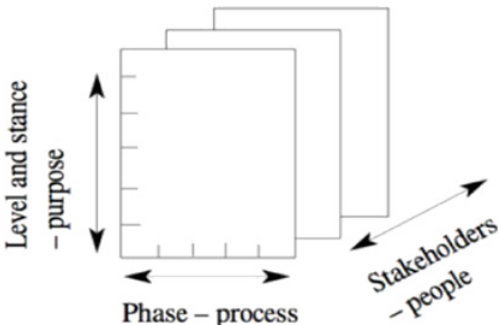
Figure 2 Three dimensions of the framework Source: (Wilcox,